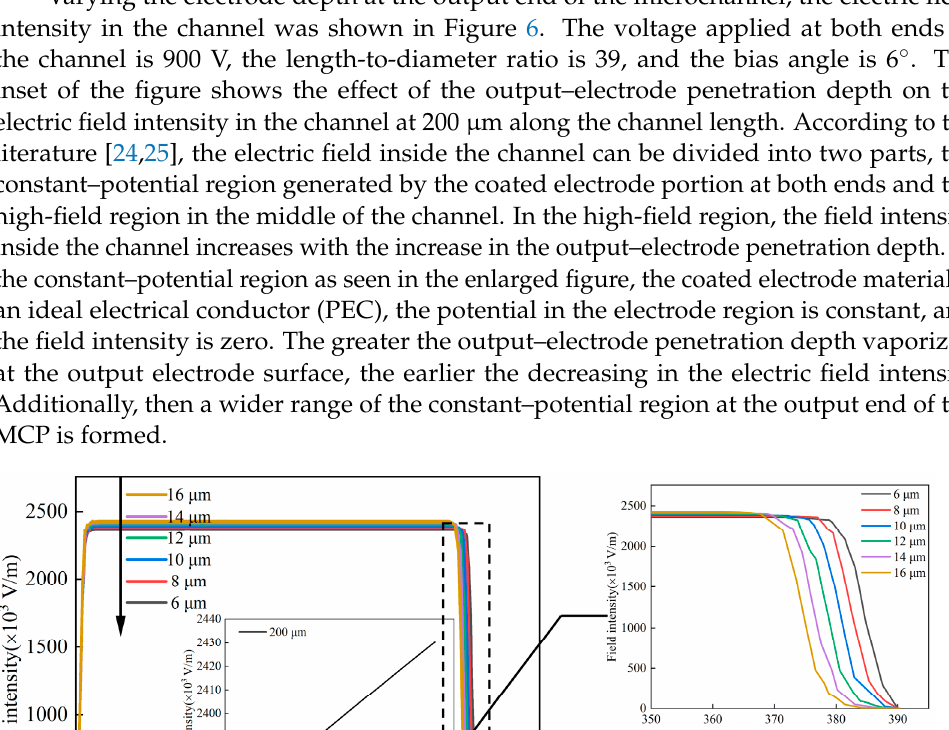
electric field intensity and the output–electrode penetration depth simultaneously. The